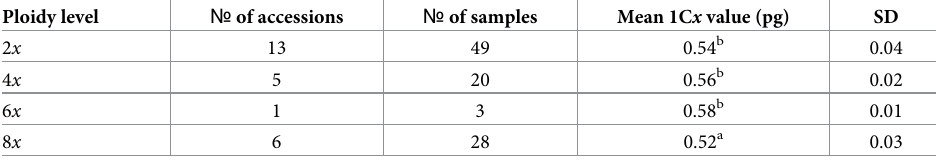
Different letters in the column show significant differences, Tukey’s b test, α = 5%, SD: standard